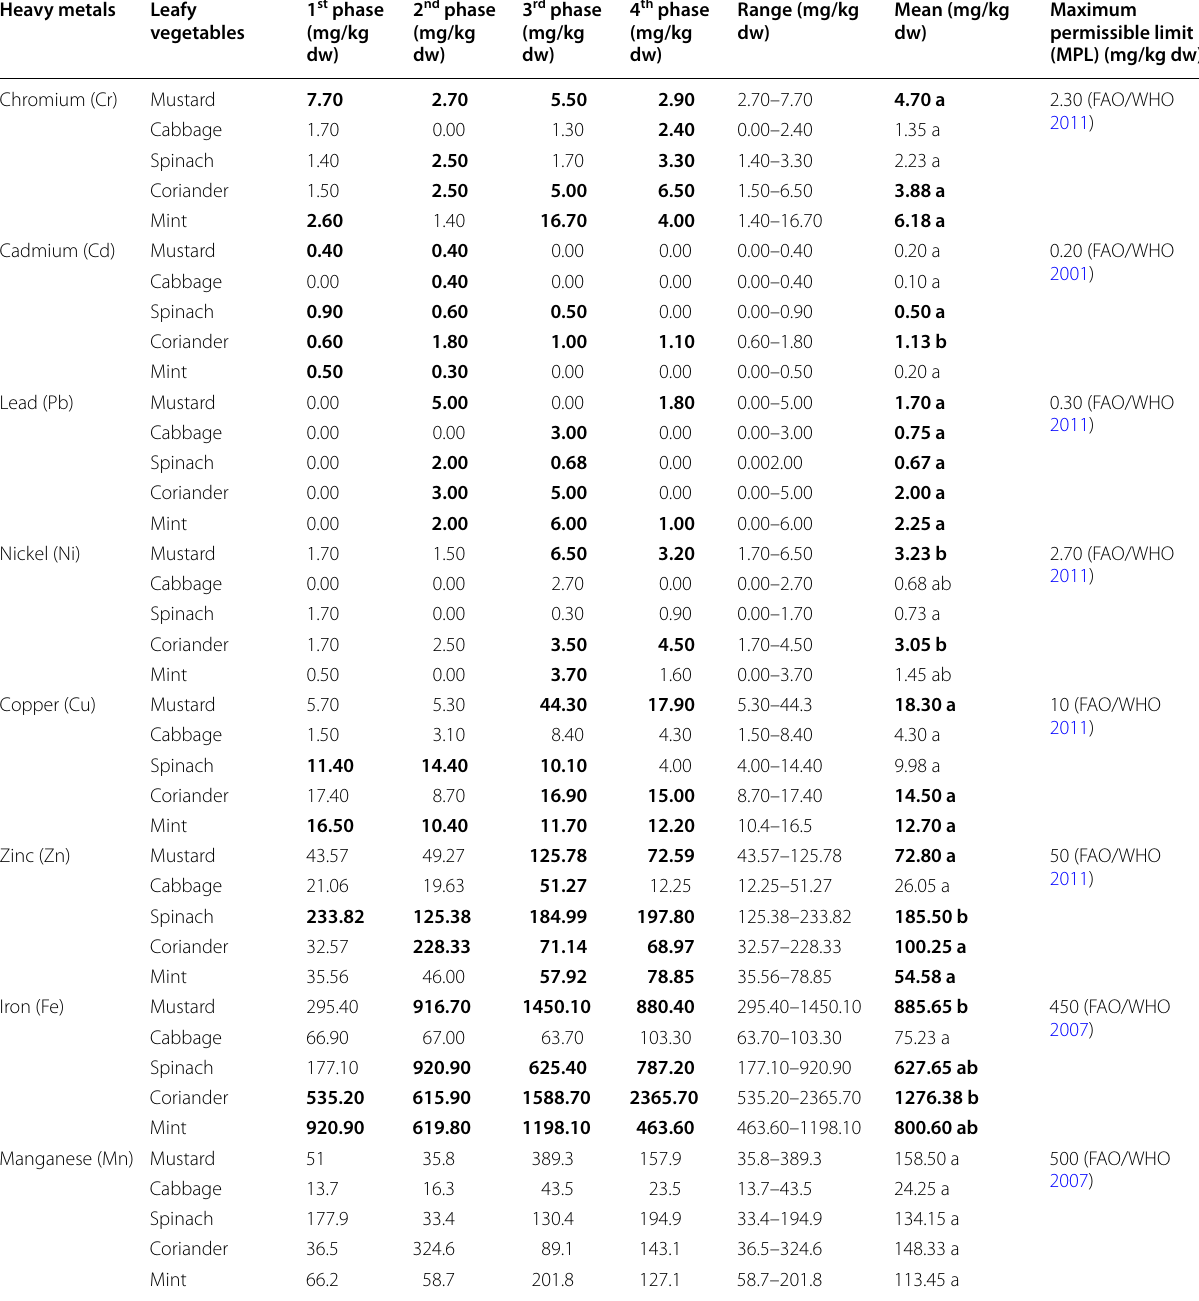
*DMRT analysis has been performed separately for each heavy metal. Mean values with the same letter(s) in a column of an individual heavy metal state no significant difference from each other at a 5% level by DMRT. The values in bold exceeded the maximum permissible limit set by the